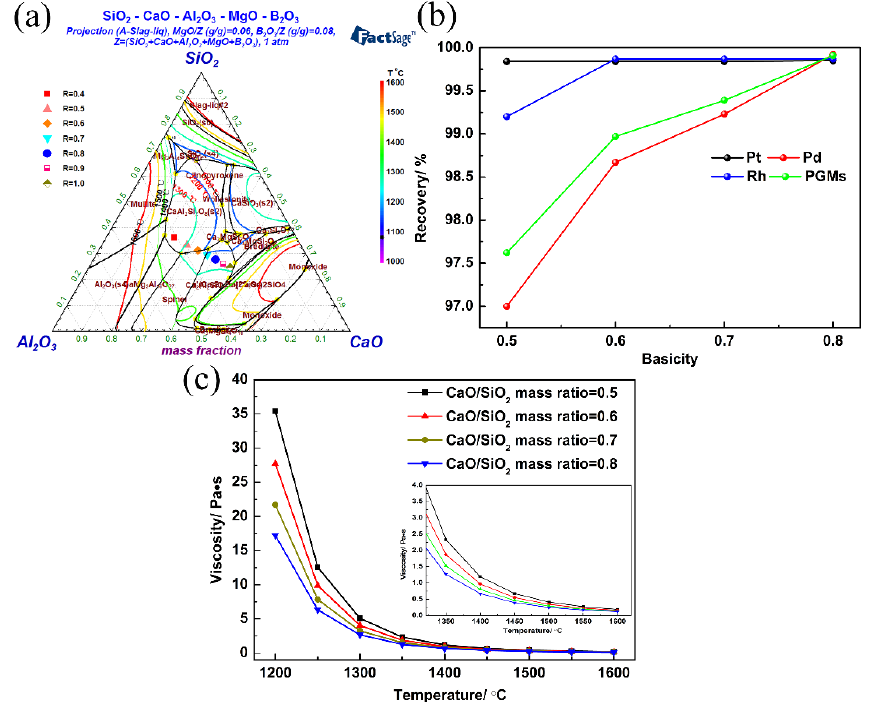
Figure 4. The phase diagram of mixed wastes SAC and RM under different basicity: ( a ) effect of basicity on the PGM recovery ( b ) (RM addition of 40 wt%, H 3 BO 3 addition of 14 wt%, smelting temperature of 1500 °C, and holding time of 40 min), and curve of viscosity and temperature for different basicity ( c ).